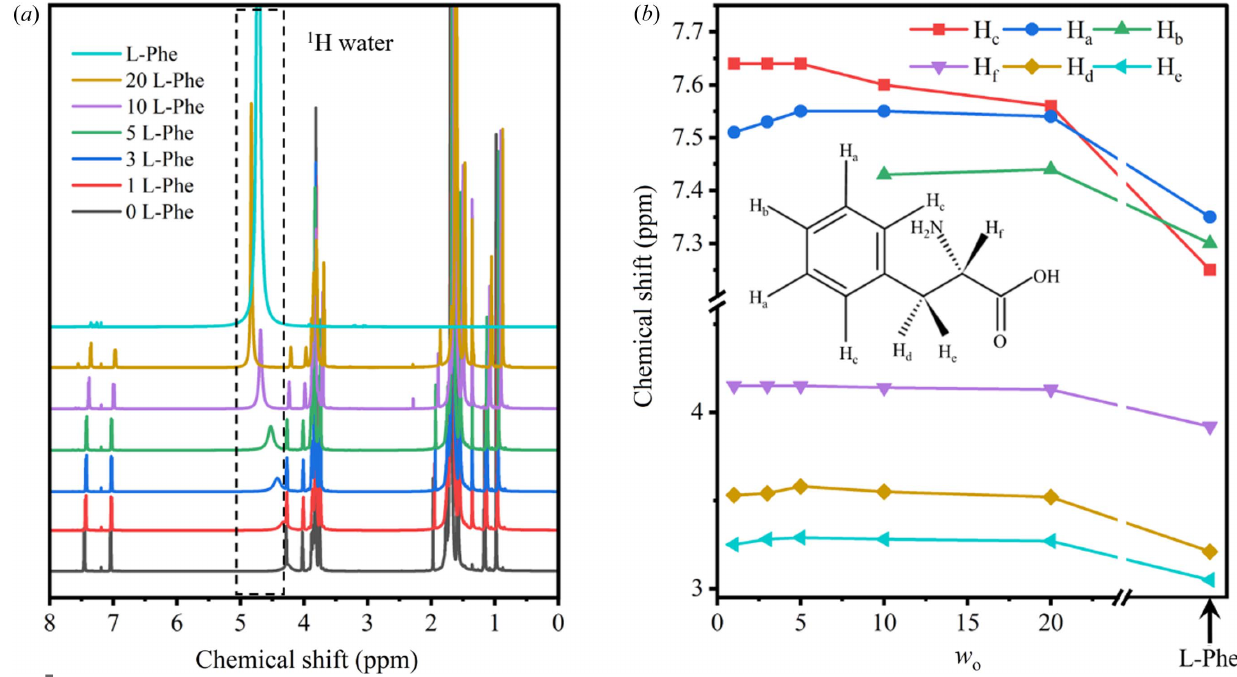
Figure 5 ( a ) 1 H NMR spectra of l -Phe-ME with different w o and l -Phe bulk solution ( l -Phe), the dashed box is 1 H of water. ( b ) Change trend of 1 H NMR of l - Phe with increasing w o , the arrow indicates l -Phe bulk solution. Due to the masking of Triton X-100, H b is absent at w o = 1, 3,